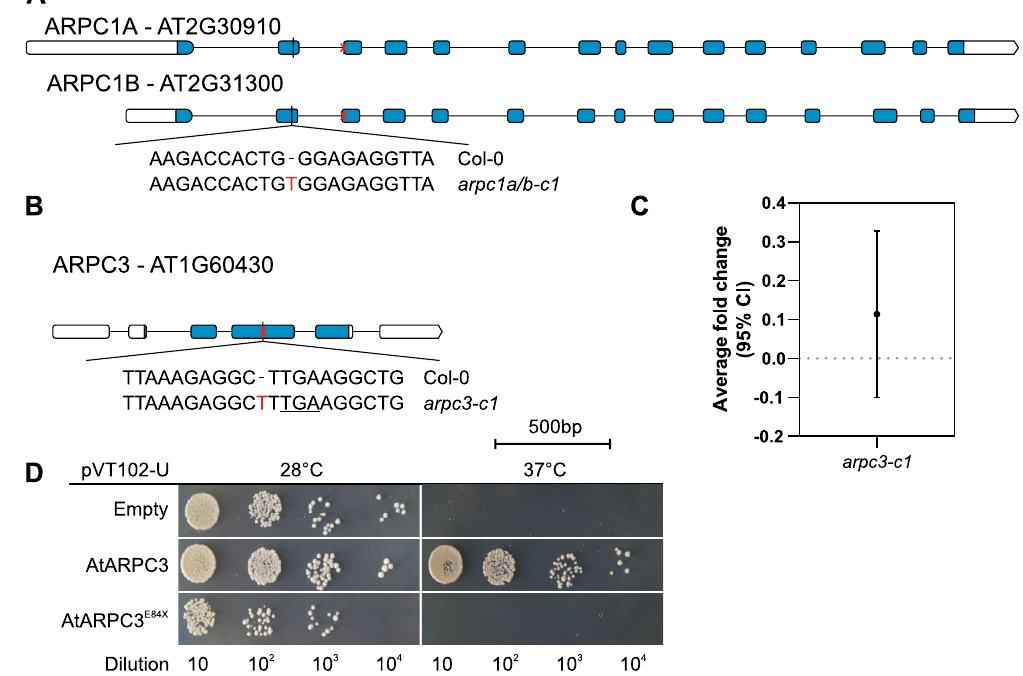
Figure 1. Characterization of the newly generated Arabidopsis thaliana CRISPR/Cas9 mutant lines arpc1a/b-c1 and arpc3-c1 . Schematic representation showing the position of the single-nucleotide insertions leading to frameshift mutations and early transcript termination for both ( A ) ARPC1A/ARPC1B and ( B ) ARPC3 genes. ( C ) Further molecular characterization of the arpc3-c1 line via qRT-PCR with specific primers for the ARPC3 coding sequence shows negligible gene expression compared to wild-type plants. ( D ) Yeast complementation assay was used to assess the functionality of both full-length and truncated versions of ARPC3 at selective temperature (37 °C). While full-length ARPC3 can recover the growth phenotype of Δarc18 yeast strains, truncated ARPC3 fails to reinstate its viability. Serial yeast culture densities were